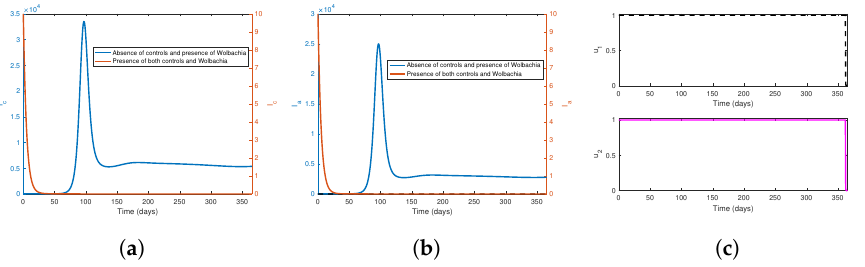
Figure 11. Plots ( a,b ) are the plot of infected children and adult individuals, respectively. Plot ( c ) is the control